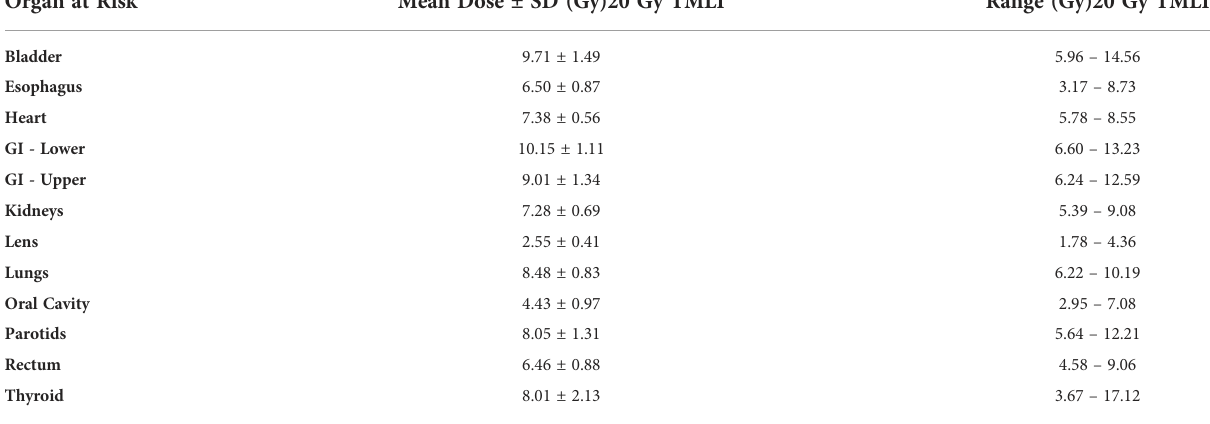
TABLE 2 Summary of mean organ dose (Gy) for patients treated with 20 Gy TMLI (n = 120). Organ at Risk